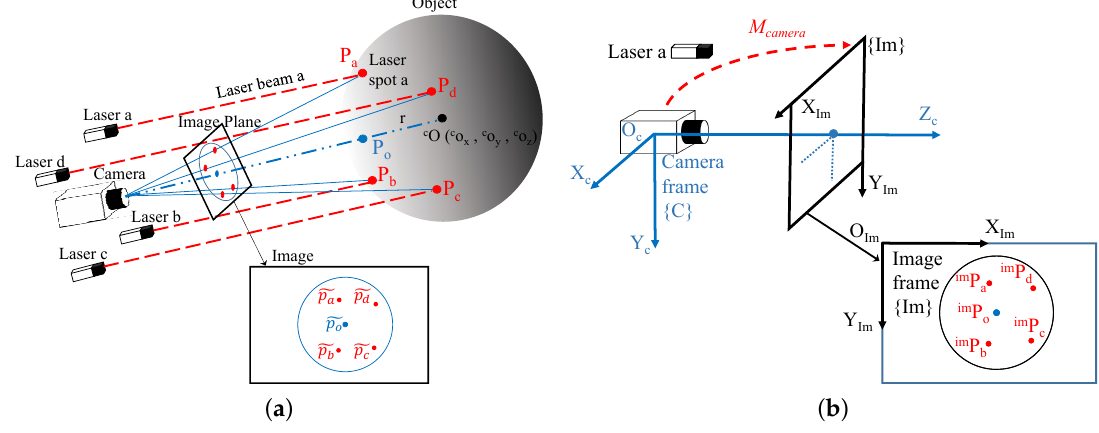
Figure 3. Illustration of the measurement method: ( a ) design of the measurement method; ( b ) diagram of the measurement reference coordinate